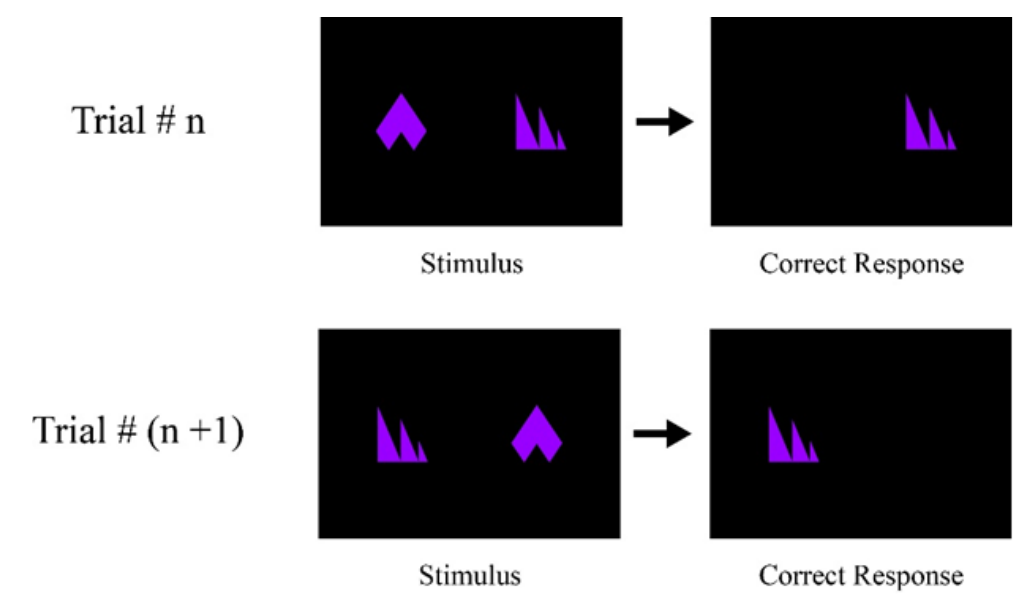
Example Trials for the Concurrent Discrimination (CD)